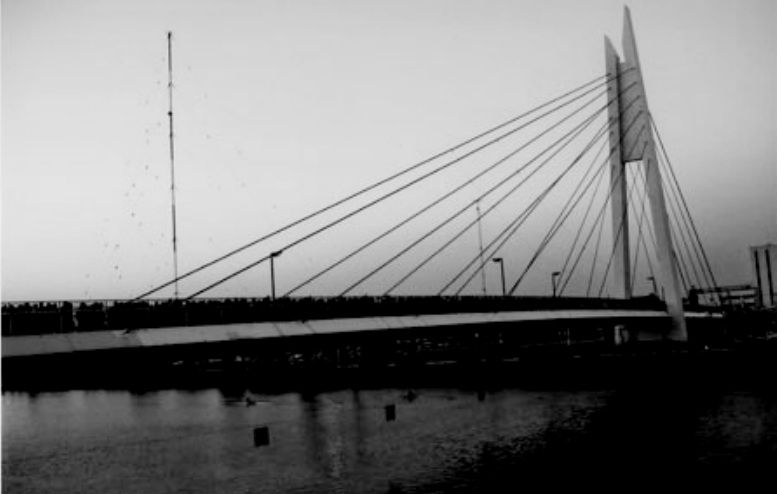
Fig. 1. Outside appearance of T-Park